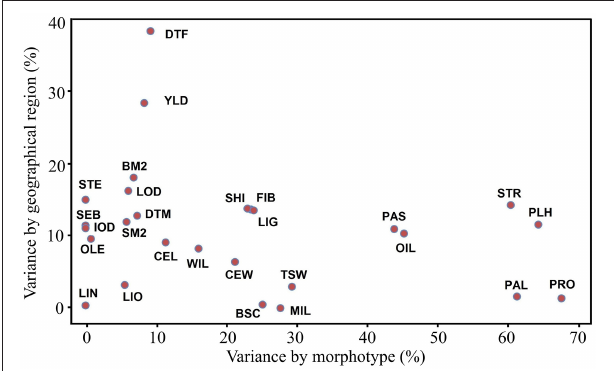
FIGURE 1 | Bi-plot of the phenotypic variation of 27 traits explained by morphotype and geographical origin. The variances explained by morphotype, geographical origin and other factors were standardized to percentages (%) based on the total variance for each trait. BM2, bolls m − 2 ; BSC, branching score; CEL, cellulose (%); CEW, cell walls (%); DTF, days to flowering; DTM, days to maturity; FIB, fiber (%); IOD, iodine value; LIG, lignin (%); LIN, linolenic (%); LIO, linoleic (%); LOD, lodging score; MIL, powdery mildew rating; OIL, oil content (%); OLE, oleic (%); PAL, palmitic (%); PAS, pasmo rating; PLH, plant height (cm); PRO, protein content (%); SEB, seeds boll − 1 ; SHI, shive (%); SM2, seeds m − 2 ; STE, stearic (%); STR, straw weight (g); TSW, thousand-seed weight (g); YLD, seed yield (t ha − 1 ); WIL, fusarium wilt ·